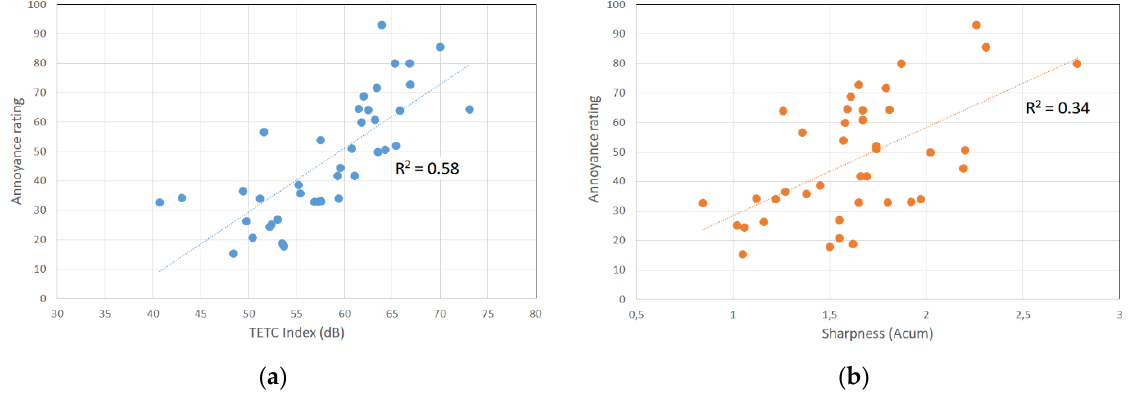
Figure 7. ( a ) The relationship between perceived annoyance ratings and the TETC index. ( b ) The relationship between perceived annoyance ratings and sharpness.